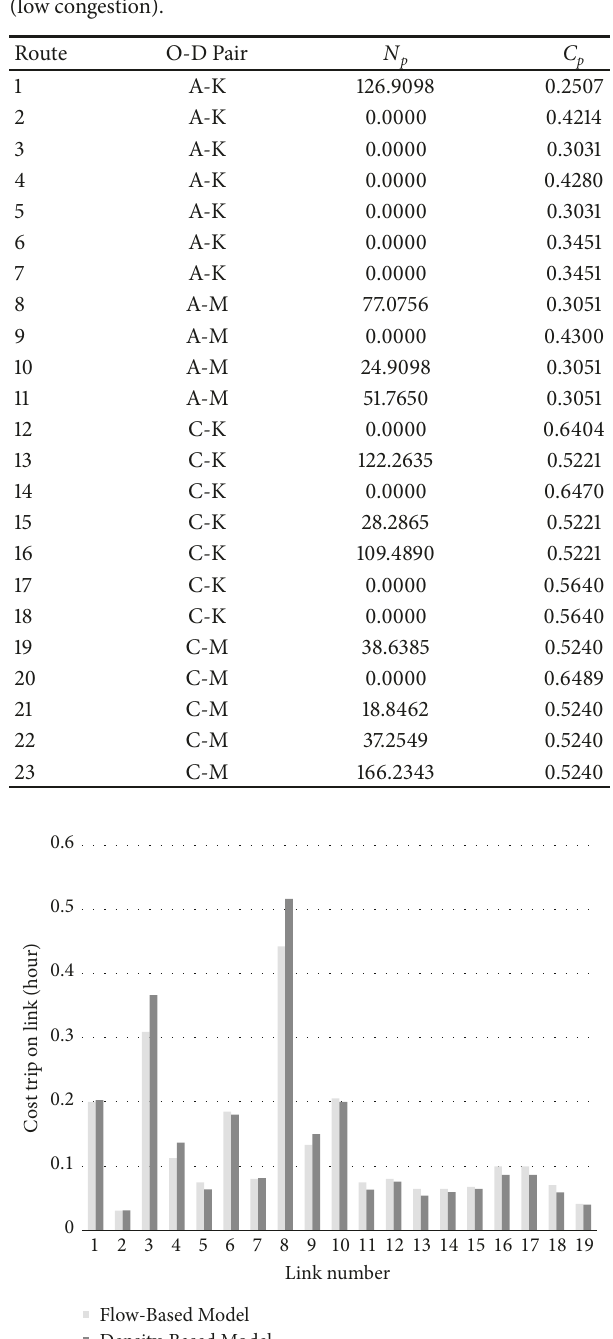
Table 5: Equilibrium Route Assignments, Density-Based Approach (low congestion).